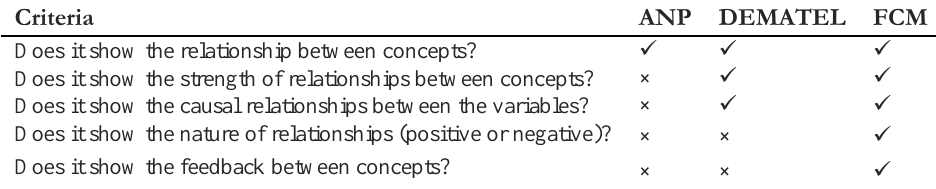
Table 1. Comparison between possible